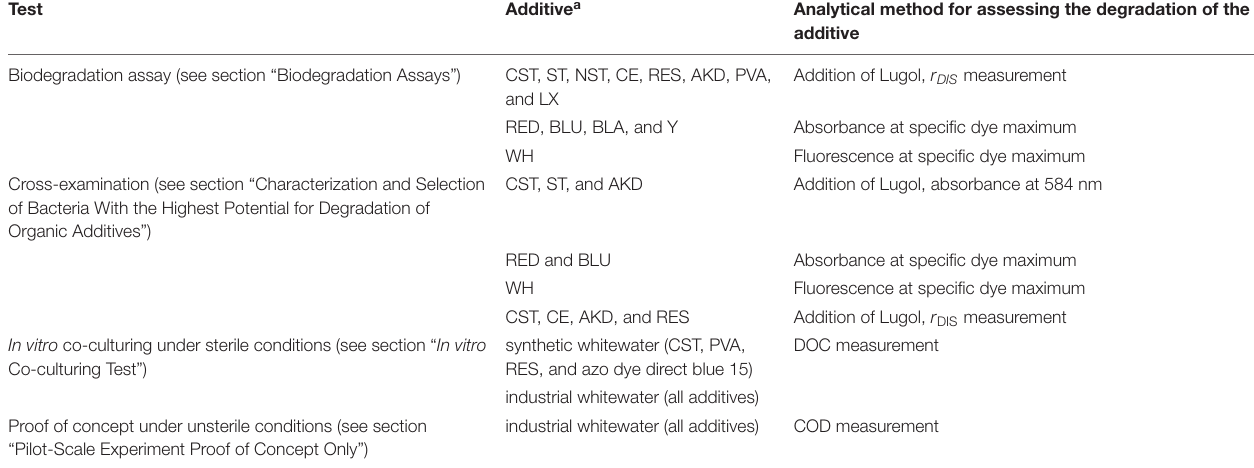
TABLE 1 | Selection tests for building an artificial consortium and analytical methods to evaluate degradation of the additives.